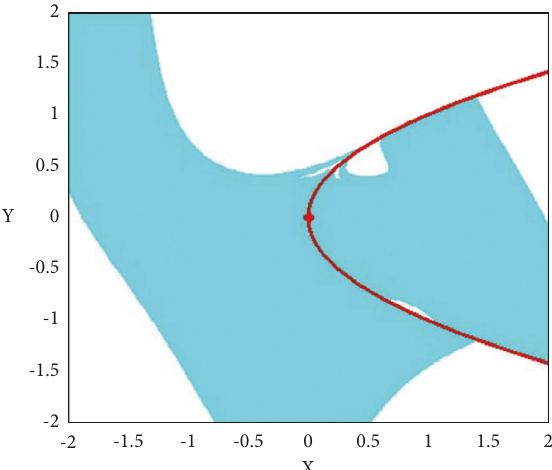
Figure 4: Cross section of the basins of attraction of the two attractors in the xy -plane at z 0. Initial conditions in the white (cid:31) region lead to unbounded orbits, those in the red region are exactly on the curve equilibrium (it can be seen that there is no basin for the curve of equilibria which proves that the equilibrium is un- stable), and those in the light blue region lead to the strange attractor shown in cross section as black dots.